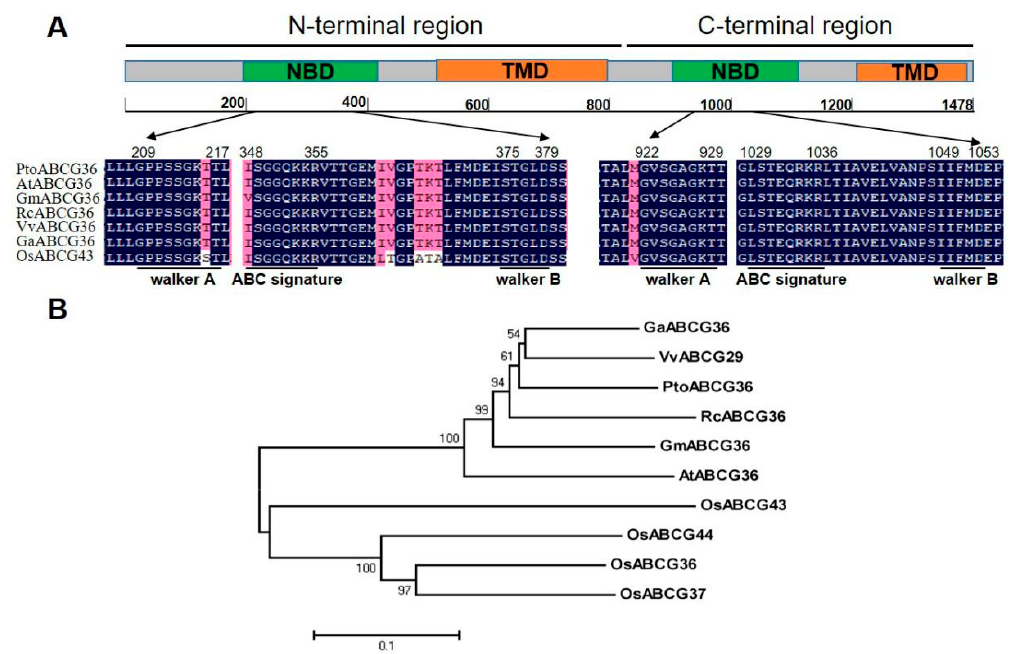
Figure 1. Amino acid sequence alignment and phylogenetic analysis. ( A ) Structure analysis and amino acid multi-alignment of the nucleotide-binding domains (NBD) of ABCG proteins from di ff erent plant species. ABCG domains are marked as two green and orange blocks. TMD, transmembrane domain; Walker A, ATP-binding cassette (ABC) signature; Walker B, NBD associated motifs. Blue indicates identical amino acids; pink indicates similar amino acids. ( B ) Phylogenetic analysis of ABCG proteins from Populus trichocarpa (PtoABCG36, MH660448); Arabidopsis thaliana (AtABCG36, NP_176196); Oryza sativa (OsABCG36, XP_015648358; OsABCG37, XP_015648329; OsABCG43, XP_015646575; OsABCG44, XP_015650488); Glycine Max (GmABCG36, XP_006585572); Ricinus conmunis (RcABCG36, XP_002515970); and Vitis vinifera (VvABCG29, XP_010654625); Gossypium arboretum (GaABCG36, XP_017606959). The numbers beside the branches represent bootstrap values based on 1000 replications.